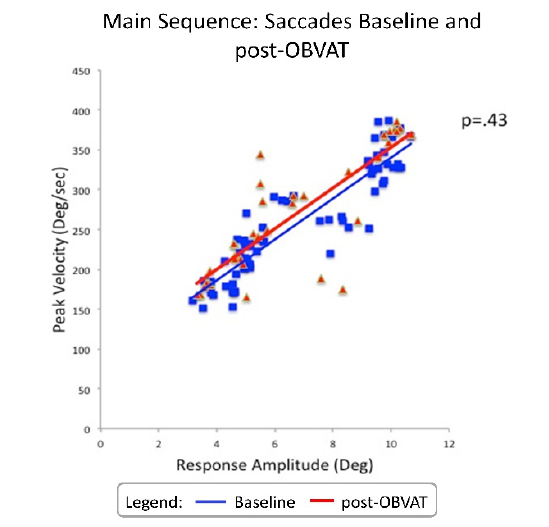
Figure 4: Main sequence for saccades pre- vs post-